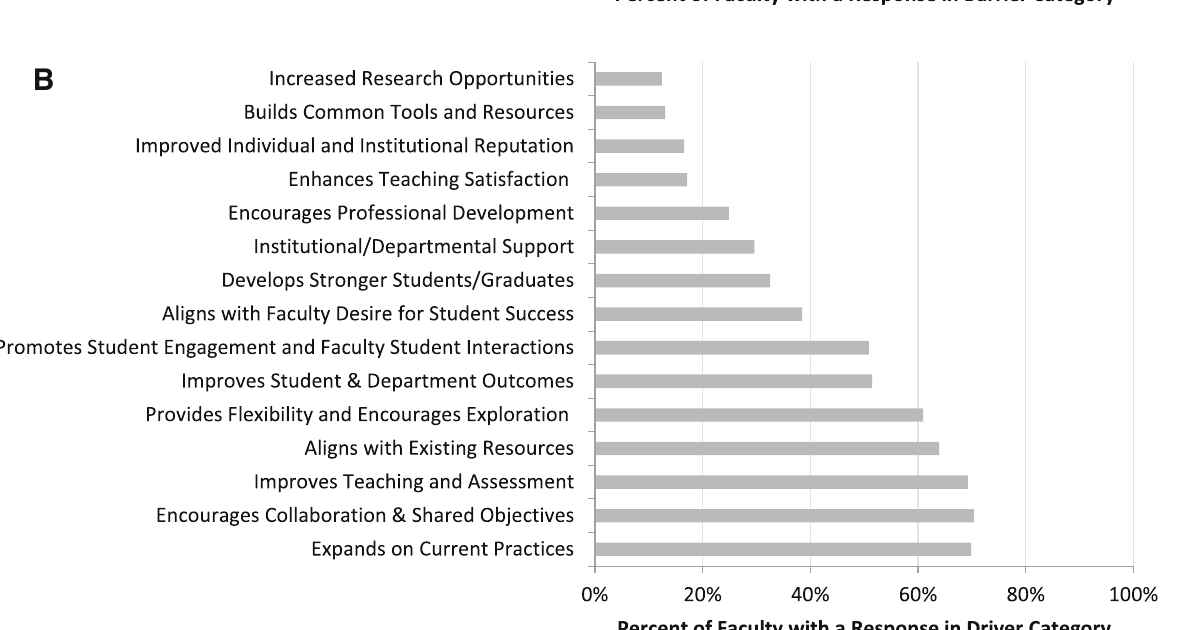
Fig. 1 Categories of barriers ( a ) and drivers ( b ) to STEM education reform. Categories were emergent based on analysis of comments from 169 faculty, aggregated across all STEM departments. The length of the bar indicates the percent of participants who had a response that was coded to the respective